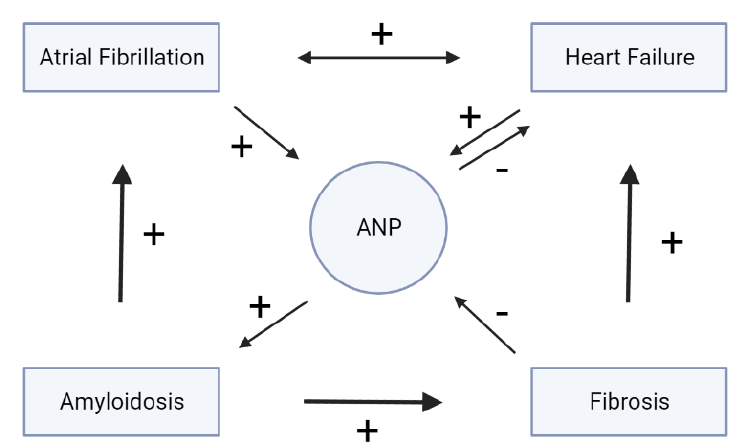
Figure 4. Relationship among AF, HF, and amyloidosis; Arrows with a (+) sign show an in- crease/promote effect, and arrows with a ( − ) sign show a reduction